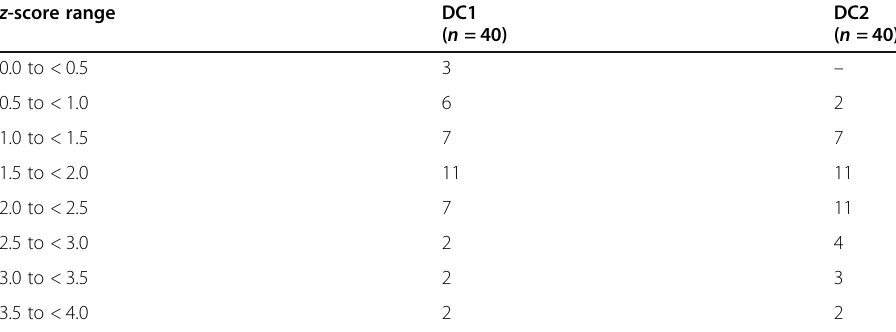
Table 7 The results of deep cohesion analysis z -score range DC1